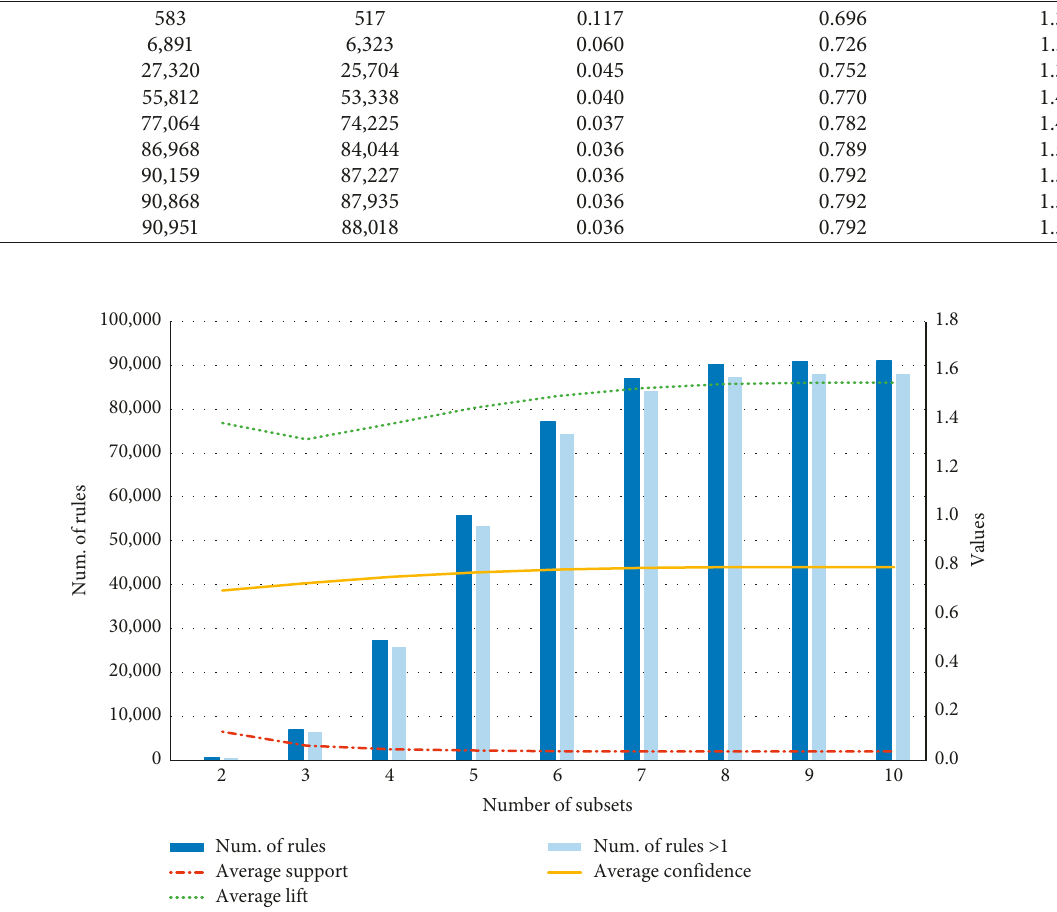
Figure 3: Graph for the association rules